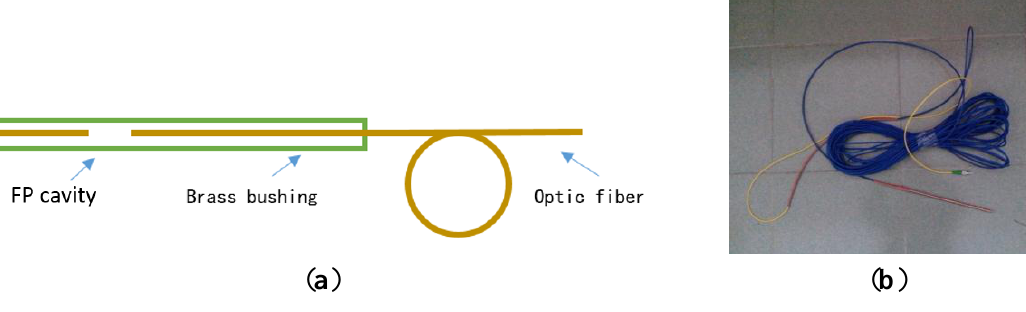
Figure 8. Schematic design and photo of the actual sensor. ( a ) Schematic design of fiber